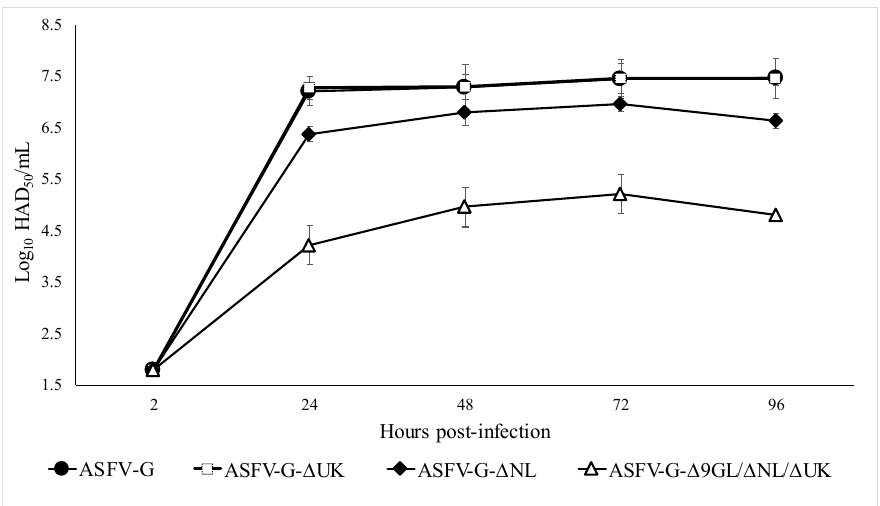
Figure 3. In vitro growth kinetics of recombinant viruses ASFV-G- Δ NL, ASFV-G- Δ UK, ASFV-G- Δ 9GL/ Δ NL/ Δ UK, and parental ASFV-G. Primary swine macrophage cell cultures were infected (MOI = 0.1) with either recombinant virus or parental ASFV-G viruses. Virus yield was estimated at indicated times postinfection by titration in primary swine macrophage cell cultures. Data represent means and standard deviations from three independent experiments. Sensitivity of virus detection: >1.8 HAD 50 /mL.